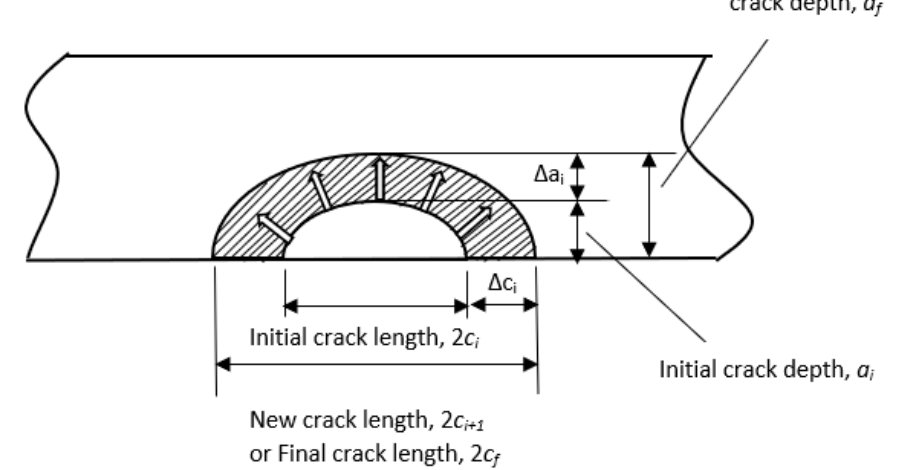
Figure 16. Schematic representation of crack shape Figure 16 . Schematic representation of crack shape evolution.